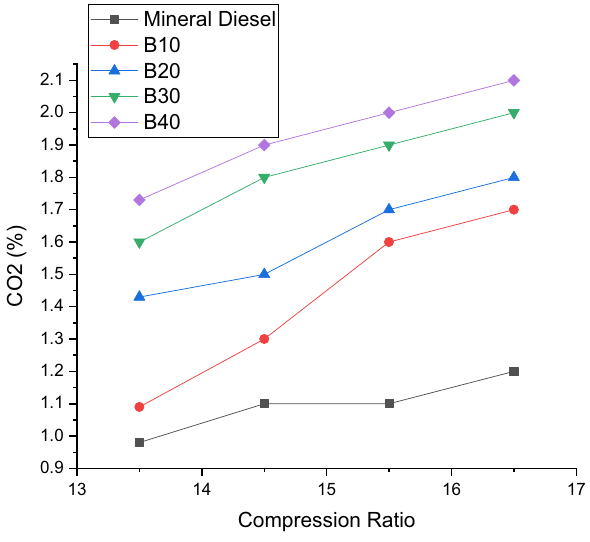
Fig. 11 Variation of carbon dioxide emissions of dual biodiesel sample blends at different compression ratios